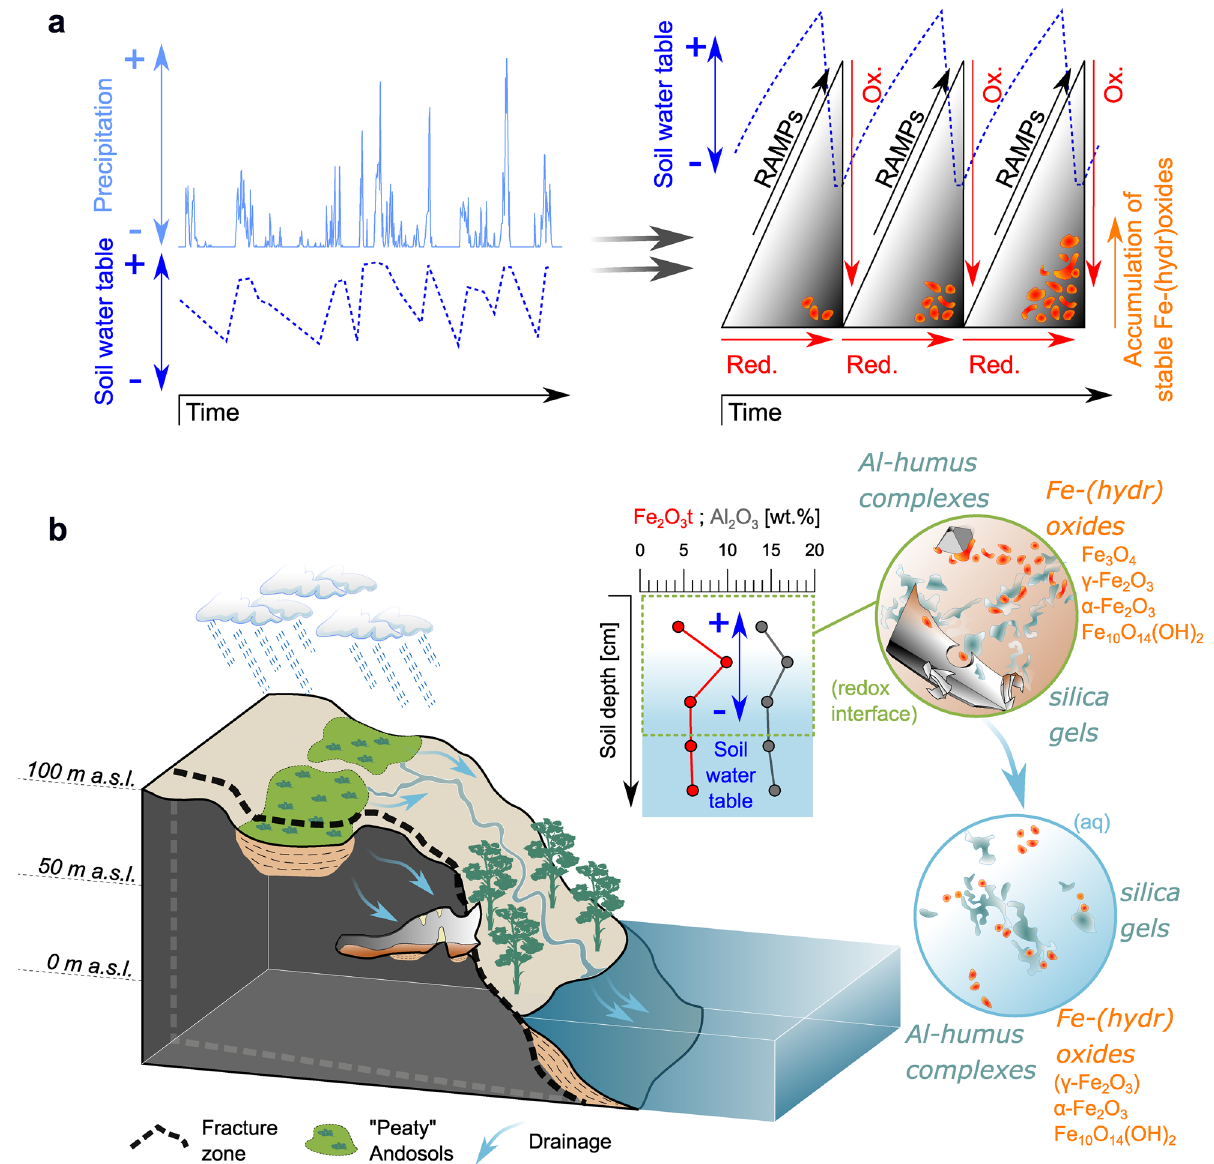
Figure 6. Synthesis of the controlling mechanisms on Fe-(hydr)oxide (trans)formation in and mobilization from peaty Andosols in this hyper-humid region. (a ) The impact of varying rainfall intensity on soil water- level fluctuations is shown. Frequently recurring hydrological disturbances modulate the soil redox state ( Red . reducing conditions, Ox. oxidizing conditions), affect iron redox cycling and lead to a continuous production of noncrystalline redox-active metastable phases (RAMPs) under reducing conditions and the precipitation of crystalline, thermodynamically stable Fe-(hydr)oxides by progressive, oxidative stages (after Peiffer et al. 23 , modified). ( b ) Schematic illustration of the study area (Klaes et al. 26 , modified) including suggested mobilization patterns of distinct Fe-(hydr)oxides accompanied by Al–humus complexes and amorphous silica originating from hydrological disturbance at the redox interface in these volcanic ash